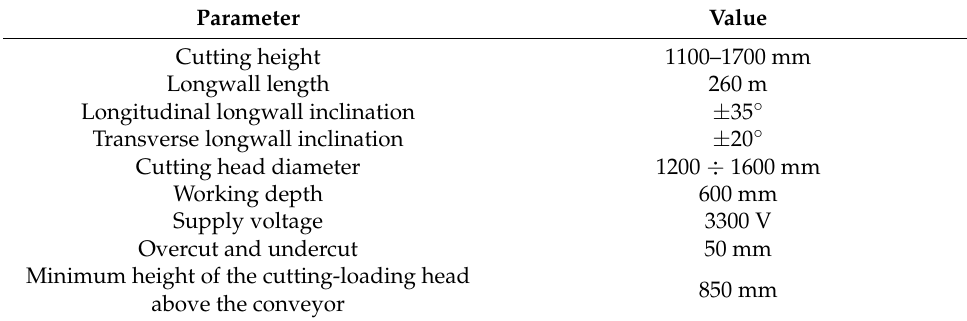
Table 1. Basic technical parameters of the system